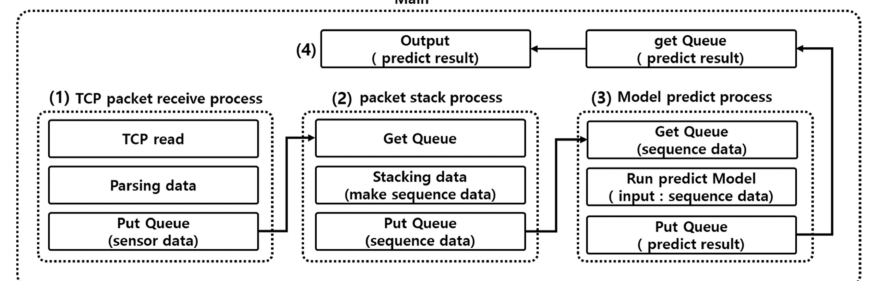
Figure 11. Real-time execution program.